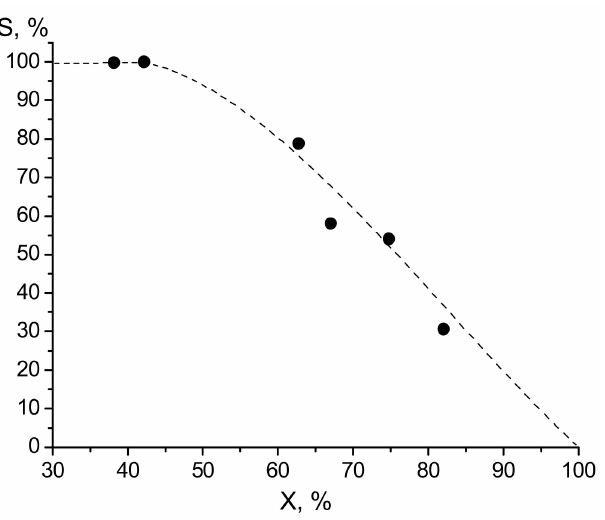
Figure 21. Selectivity of Fe 2 (MoO 4 )/MoO 3 /CaO = 1/0.7/0.3 towards CH 2 O from CH 3 OH at varying conversions at 300 ◦ C. Reprinted with permission from